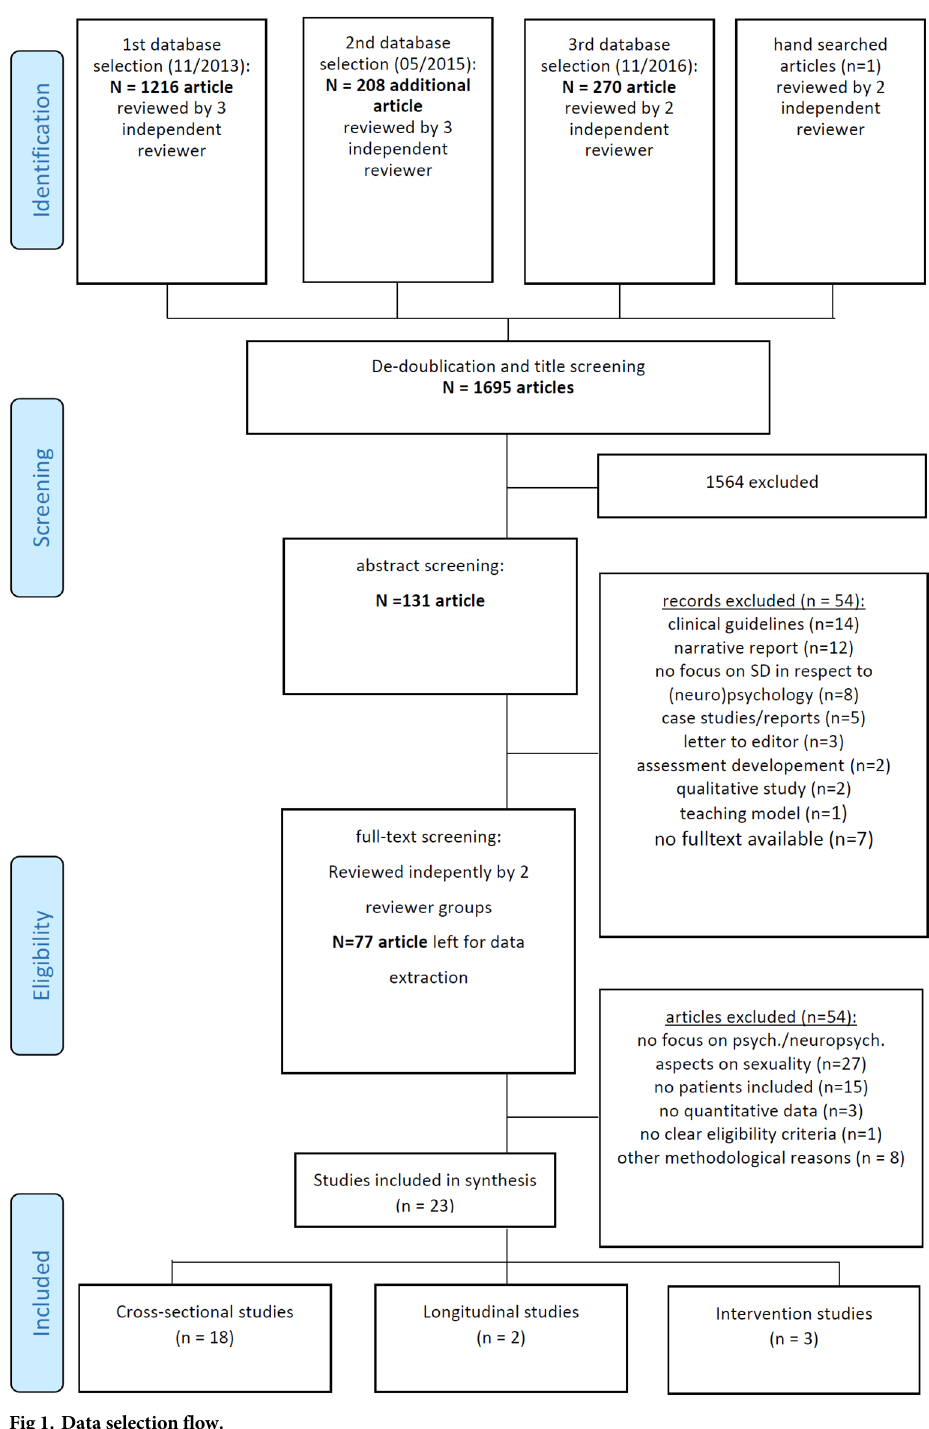
Fig 1. Data selection